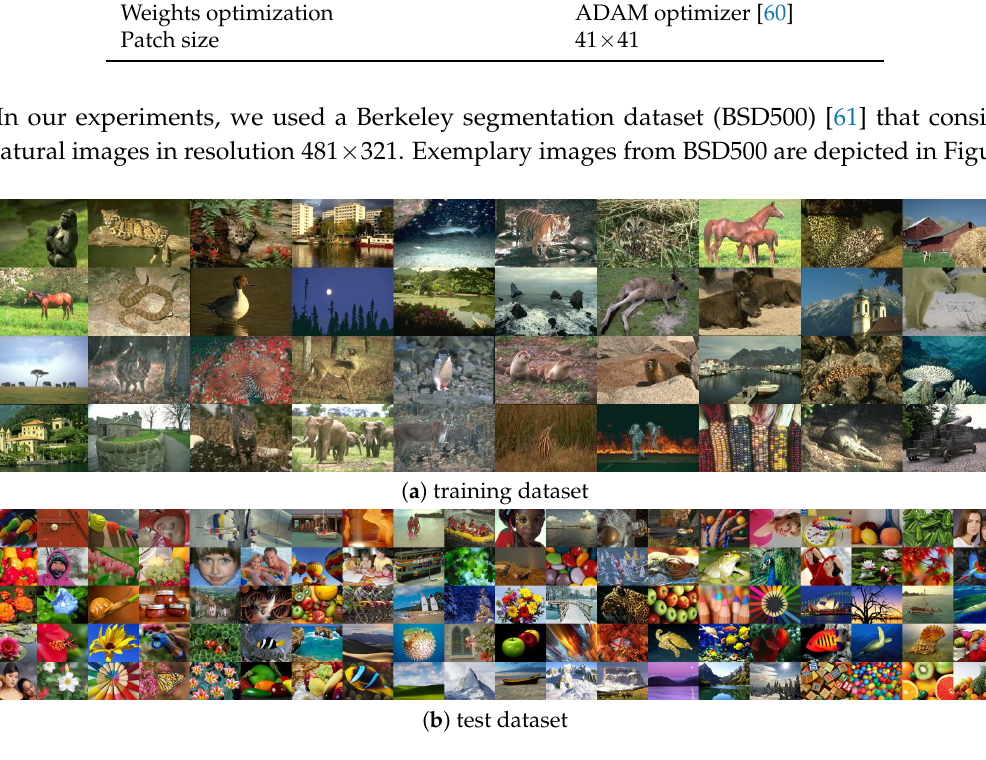
Figure 4. Example images from ( a ) Berkeley segmentation dataset (BSD500) [61] used for training purposes and ( b ) our test dataset accessible from [36] as supplementary